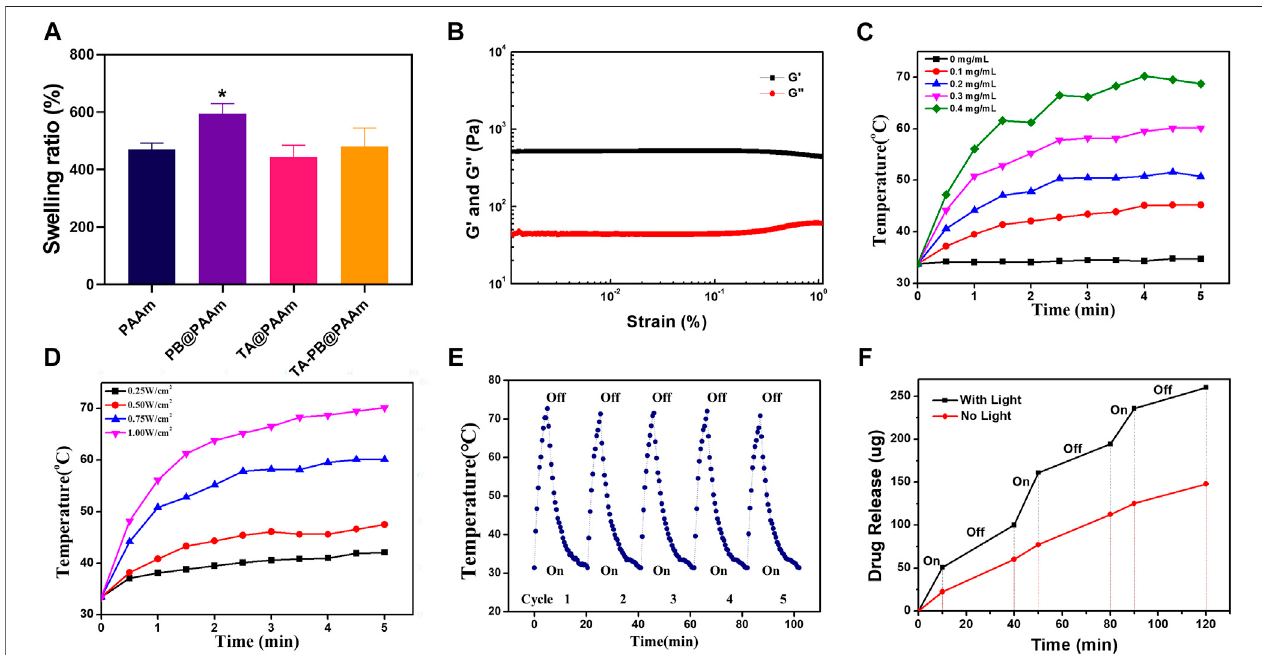
FIGURE 3 | Physical and chemical characterization of TA-PB@PAAm composite hydrogels. (A) Swelling rate for different contents of composite photothermal hydrogels. (B) The preservation modulus G ′ is always higher than the loss modulus G ″ , which proves that the material has good crosslinking performance. (C) Photothermal effect curve for different PB concentrations. (D) Photothermal effect curve under different illumination intensities. (E) Curve of temperature changes after cyclic illumination of the hydrogels. (F) Drug release curve under alternating light.